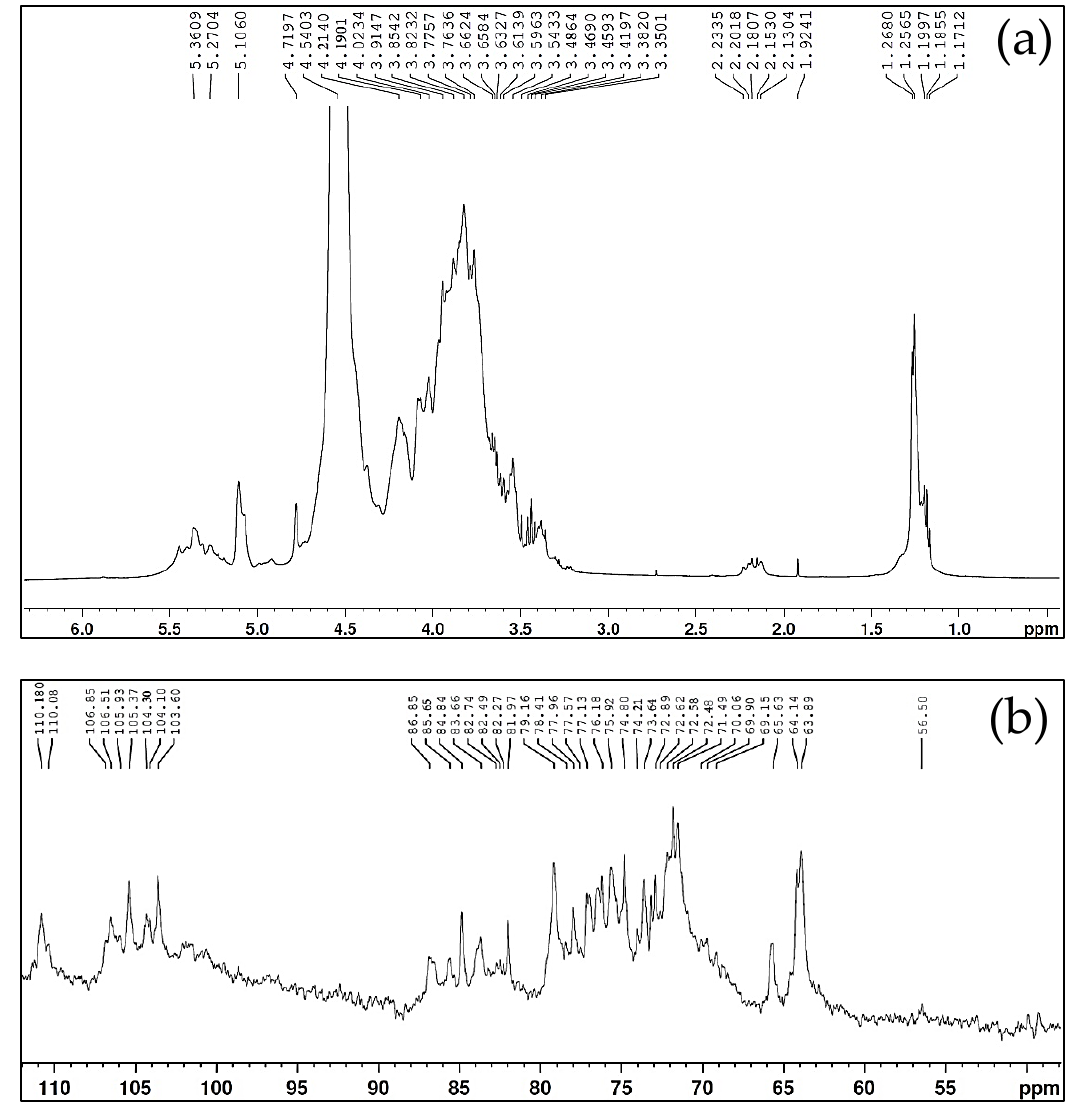
Figure 2. NMR spectra ( a ) 1 H and ( b ) 13 C of BG. Table 1. Comparison between theoretical and experimental 13 C NMR chemical shifts (ppm) for β -D-Galp and β -D-Xylp residues. Position Experimental Theoretical